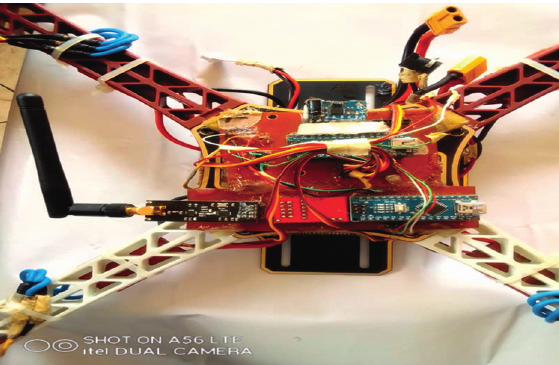
Figure 7: Mounted flight controller, transceiver, transceiver adaptor, GPS module, accelerometer, and